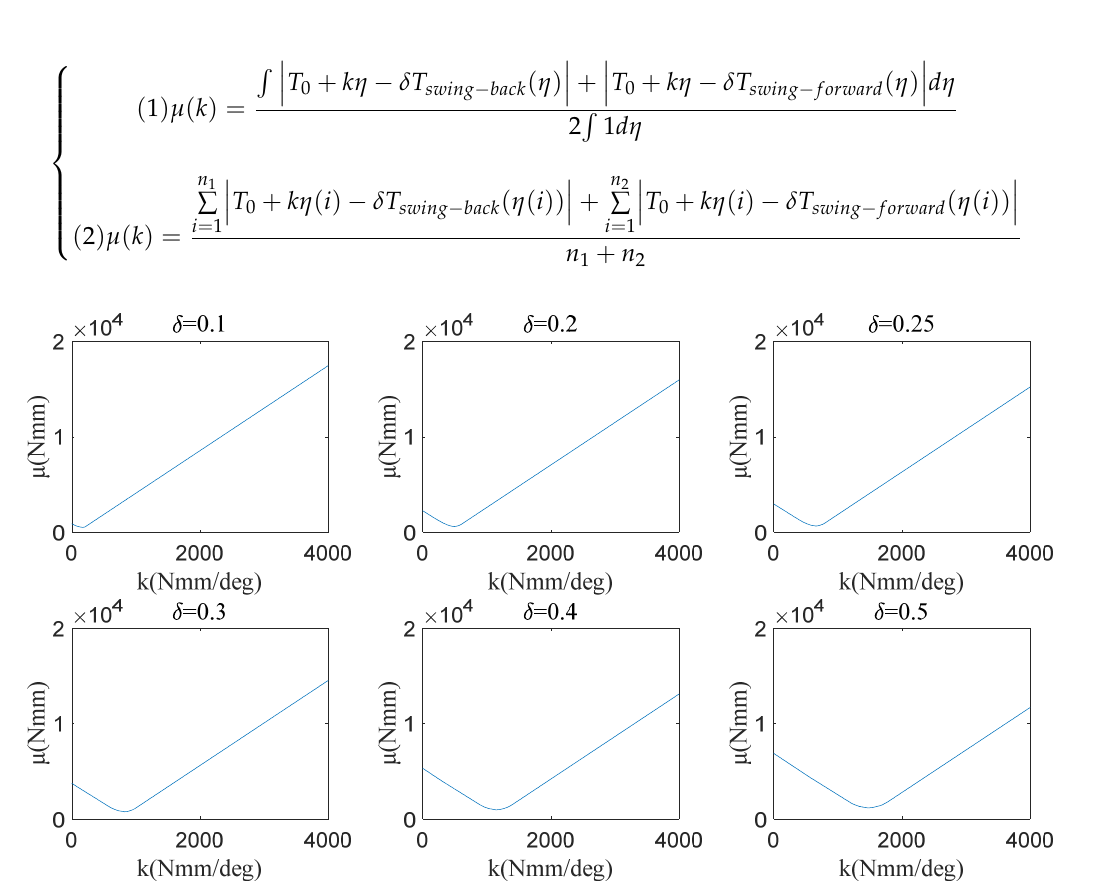
Figure 8. Dispersion value of the KESM under different parameters. As shown in Figure 9a, µ min of each δ are extracted from Figure 8, in which with the increase of δ , µ min also increases. Similar to the HESM, δ = 0.2 is chosen for the KESM. When k takes the value of 500 Nmm/deg, the KESM has the smallest average dispersion. swing back swing forward Taking into account the unidirectionality of the knee torque during the support period, 500 Nmm/deg is theoretically the best choice. The torque equation of the torsional spring is shown in Equation (11), and its curve is shown in Figure 9b.